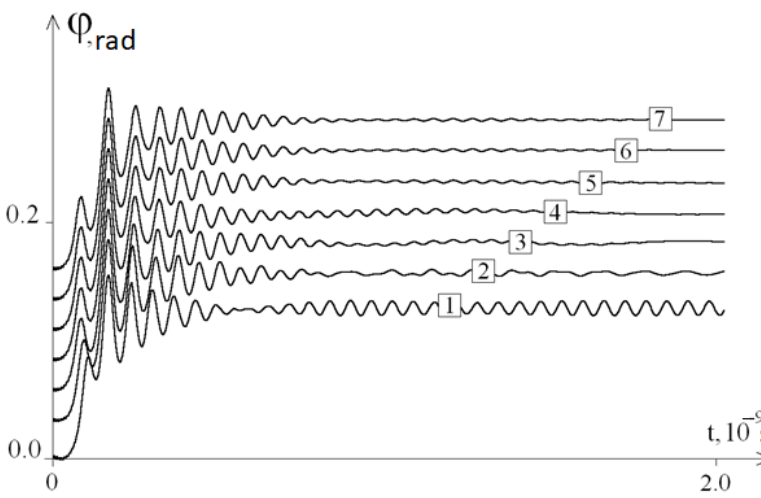
Figure 2. The average angular deviations (with vertical shift) of the first chain of the DNA molecule for different values of the frequency of external periodic impact: 1— ω =10 11 s –1 , 2— ω =5·10 10 s –1 , 3— ω =10 10 s –1 , 4— ω =5·10 9 s –1 , 5— ω =10 9 s –1 , 6— ω =10 8 s –1 , and 7— ω = 0.